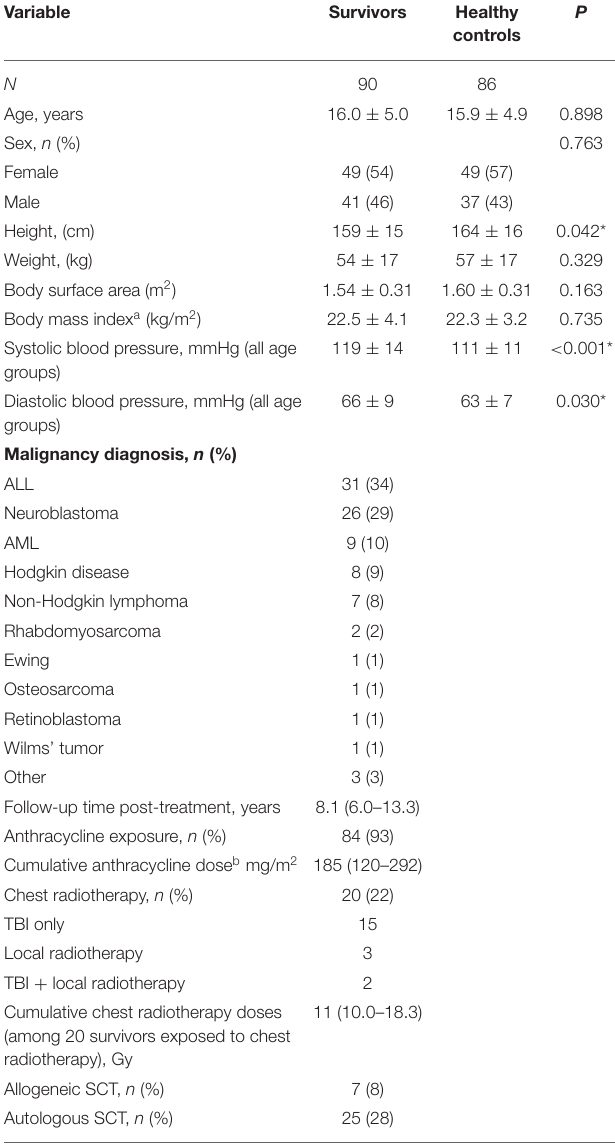
TABLE 1 | Baseline characteristics of the study subjects. Variable